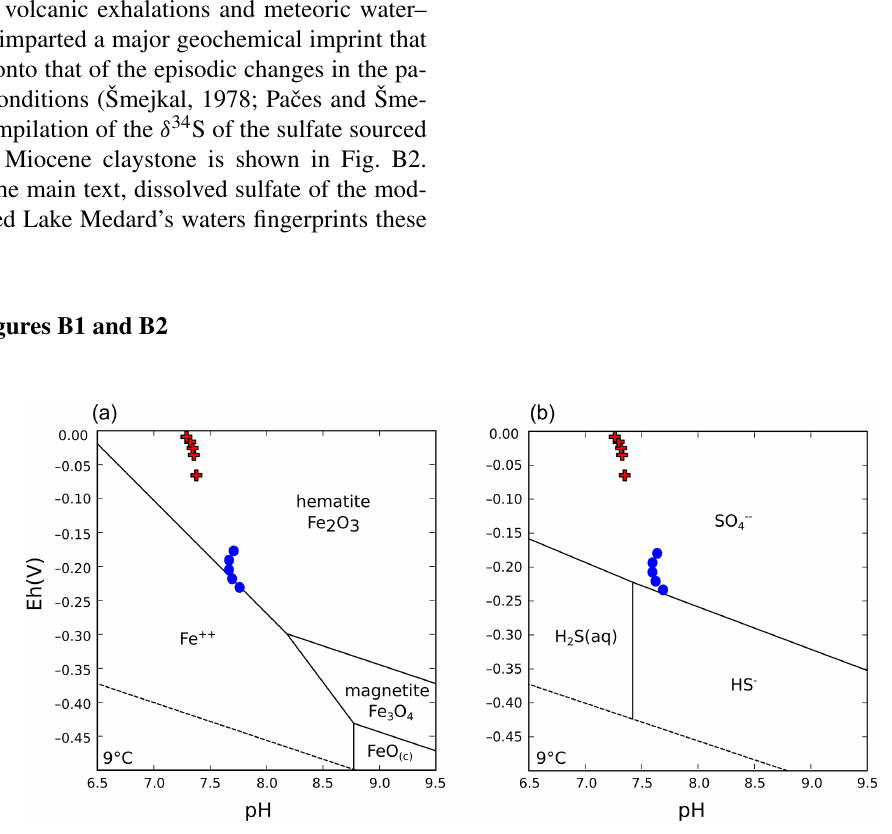
Figure B1. Pourbaix diagrams of the thermodynamically stable Fe and S phases in the bottom waters of Lake Medard at the time of sampling (dots). Also shown are modelling results of Eh–pH parameters measured when the redoxcline shifted downwards and mean mon- imolimnion’s Eh transiently changed from < − 200 to − 80mV (crosses). Variation in these physicochemical parameters coincides with seasonal hydrological dynamics of the local watershed and its effects over groundwater influx. Seasonal, short-lived shifts in conditions at the monimolimnic ferruginous waters favour Fe(III)-oxyhydroxide precipitation. Produced using the free Community Edition of The Geochemist’s Workbench ® .